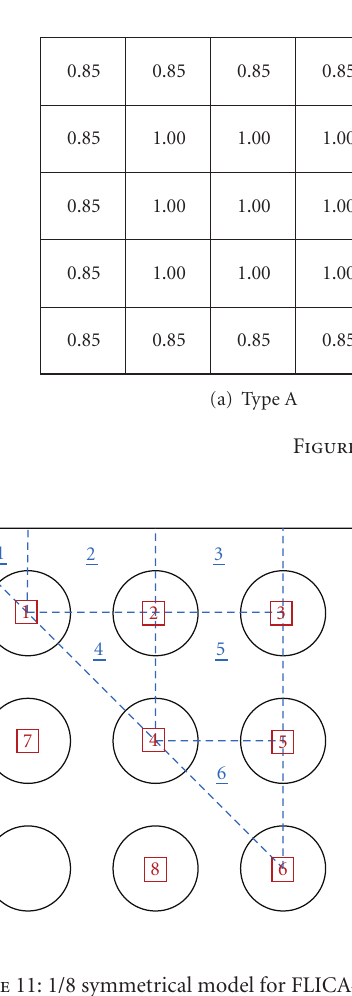
Figure 11: 1/8 symmetrical model for